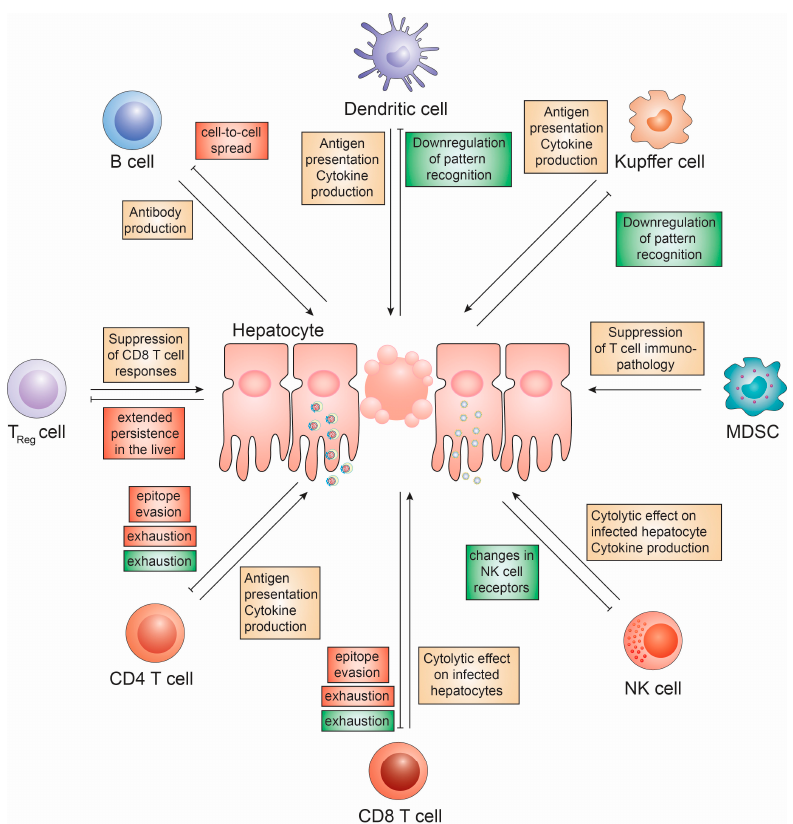
Figure 3. Cell based innate and adaptive immune responses to HBV and HCV infection. The role of innate immune cells (Kupffer cells, myeloid-derived suppressor cells (MDSC), NK cells and Dendritic cells) and adaptive immune cells (B cells, CD4 T cells, CD8 T cells and regulatory T cells) on HBV and HCV infection and mechanisms devised by HCV (red) and HBV (green) to subvert these.